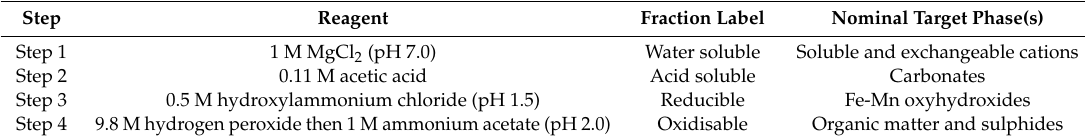
Table 1. Steps for sequential extraction.